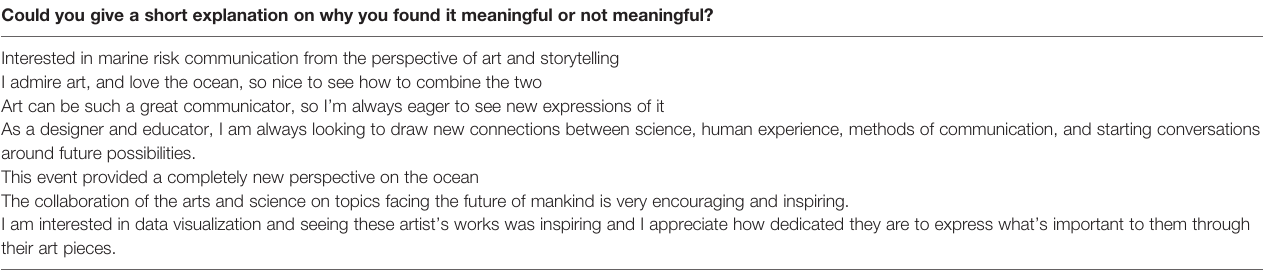
TABLE 2 | Selected audience explanations for why they found the event